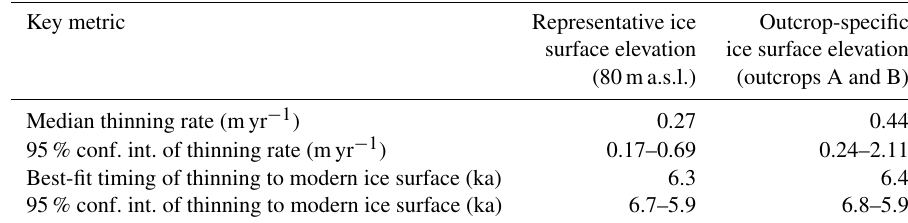
Table C1. Comparison of key metrics (thinning rate and timing) output from our preferred thinning history calculated from sample set 4 using a single measured representative ice surface elevation (80ma.s.l.) to outputs from our sensitivity test calculated using outcrop-specific ice surface elevations for outcrop A and outcrop B (Fig.